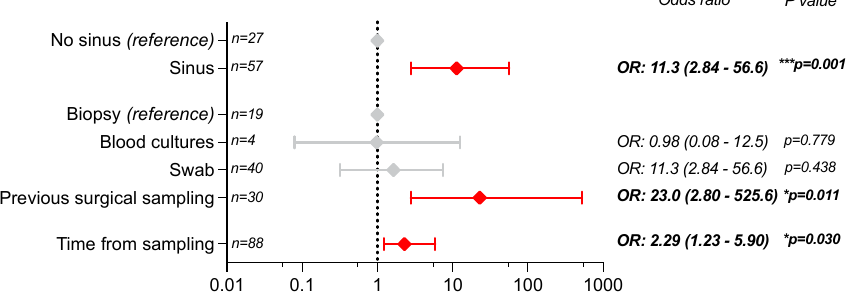
Figure 3. Outcomes of pre-referral microbiology compared to intra-operative sampling. Compari- son of pre-referral microbiology to intra-operative sampling by ( a ) method of sampling, ( b ) timing from sampling to operative samples and ( c ) the presence of an active sinus. ‘Complete matches’ are in green, ‘partial matches’ are in orange and ‘non-matches’ are in red.